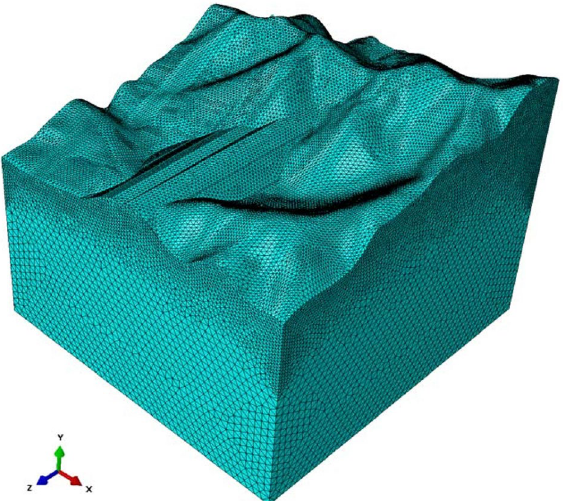
Figure 8. Grid of FEM model of Lijiazhai slope.